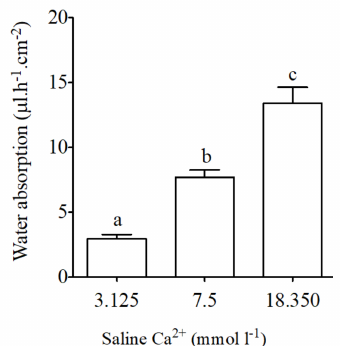
Figure 5. Water absorption ( µ L · h − 1 · cm − 2 ) as measured in intestinal sac preparations in vivo-like conditions in the anterior intestine of the sea bream in response to different concentration of calcium in apical saline (3.125, 7.5 and 18.350 mmol · L − 1 Ca 2+ in). Each bar represents the mean ± SEM ( n = 5–11). Different lowercase letters indicate significant differences ( p < 0.05, one-way ANOVA, followed by the Bonferroni’s Multiple Comparison Test).